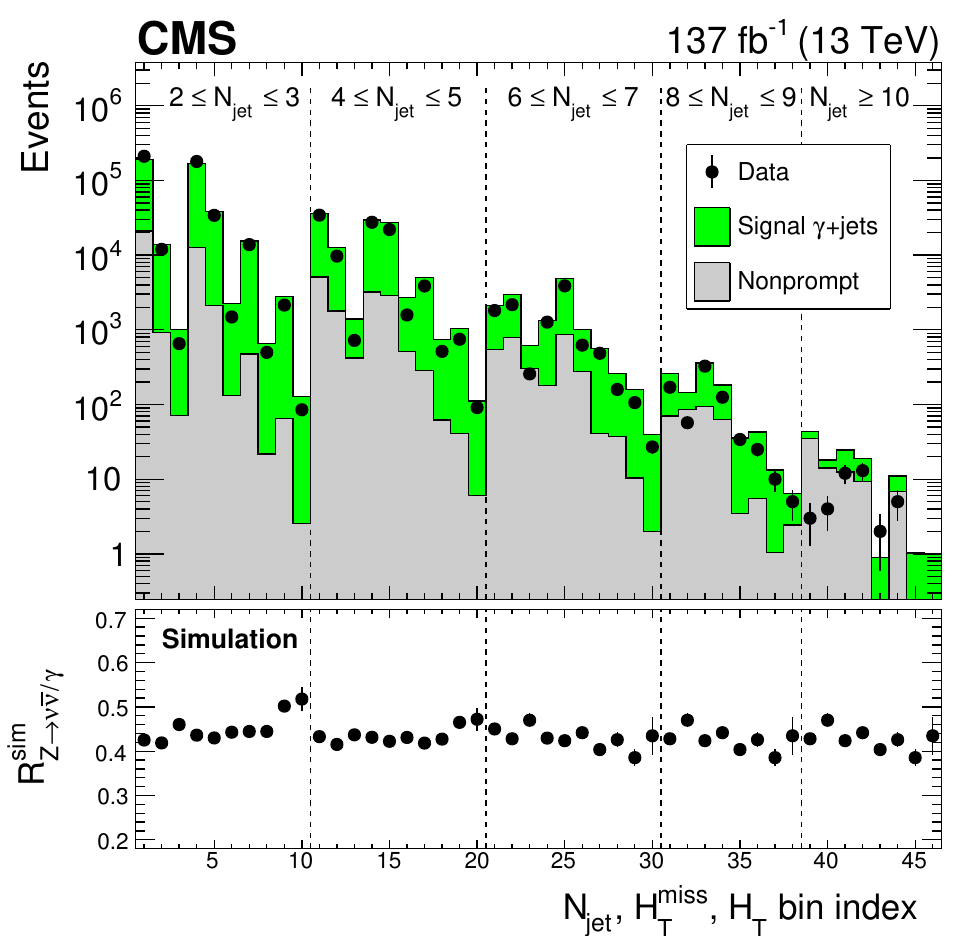
Figure 5 . (Upper) The number of events in the (cid:13) +jets control region for data and simulation. (lower) The transfer factors R sim from simulation. The respective results are shown for the Z ! (cid:23)(cid:23) =(cid:13) 46 search bins with N = 0. The 10 results (8 for N (cid:21) 8) within each region delineated by b-jet jet vertical dashed lines correspond sequentially to the 10 (8) kinematic intervals in H and H miss T T listed in table 1 and (cid:12)gure 3. The uncertainties are statistical only. For the upper plot, the simulated results show the stacked event rates for the (cid:13) +jets and nonprompt MC event samples, where \nonprompt" refers to SM MC events other than (cid:13) +jets. The simulated nonprompt results are dominated by events from the QCD sample. Because of limited statistical precision in the simulated event samples at large N , the transfer factors determined for the 8 (cid:20) N (cid:20) 9 region jet jet are also used for the N > 10 jet